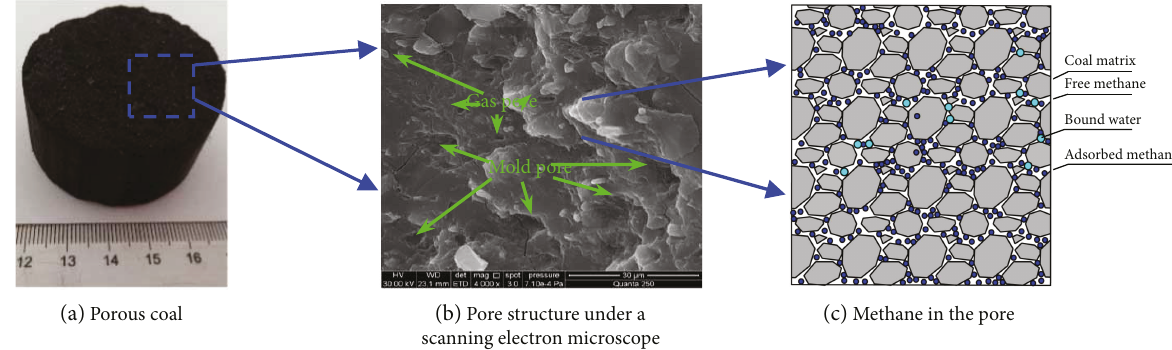
Figure 1: Methane distribution in porous